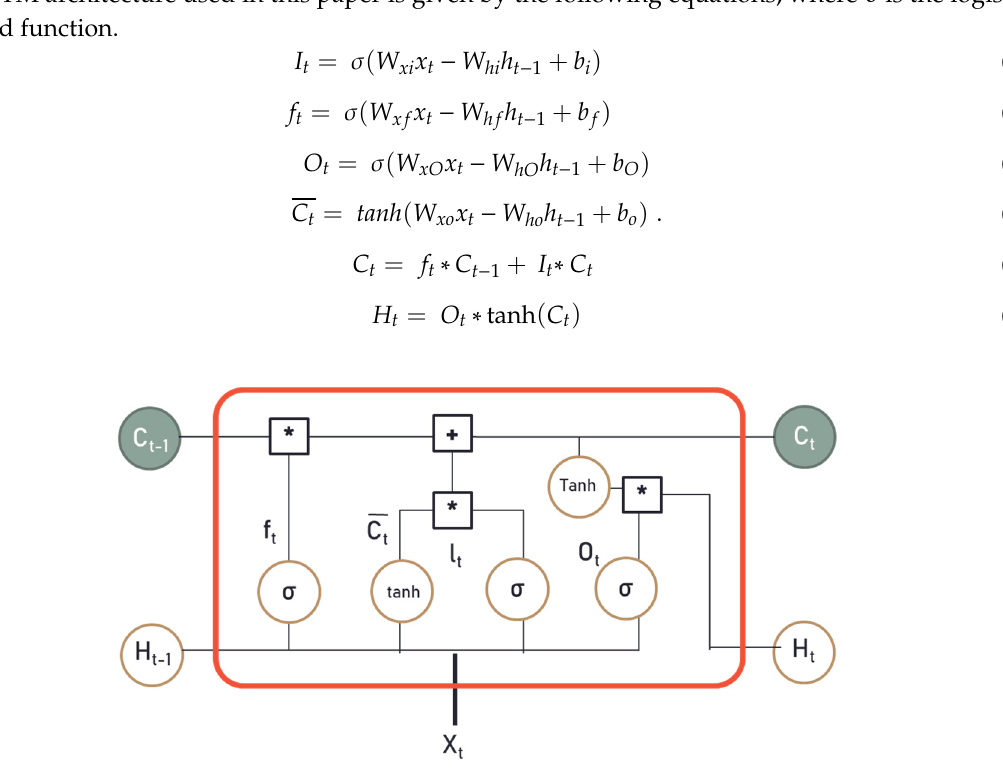
Figure 5. The diagram for an LSTM cell at time T.